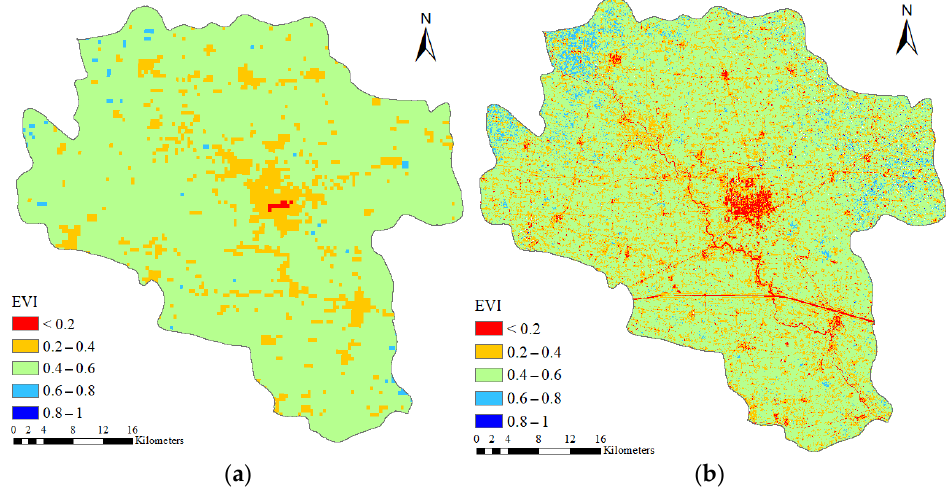
Figure 4. The data fusion effect. ( a ) MOD09A1-EVI image before fusion on 5 September 2020; ( b ) EVI image after data fusion.